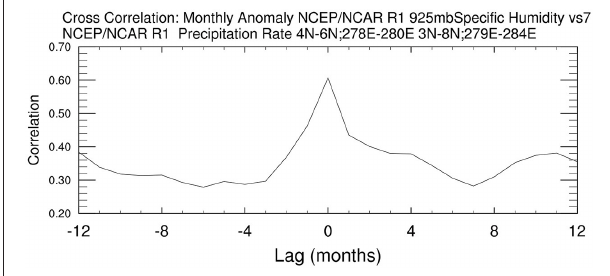
FIGURE 9 | Monthly lagged correlations between anomalies of specific humidity at 925 hPa in Choco LLJ region and precipitation rates over western Colombia. Data source: NCEP/NCAR